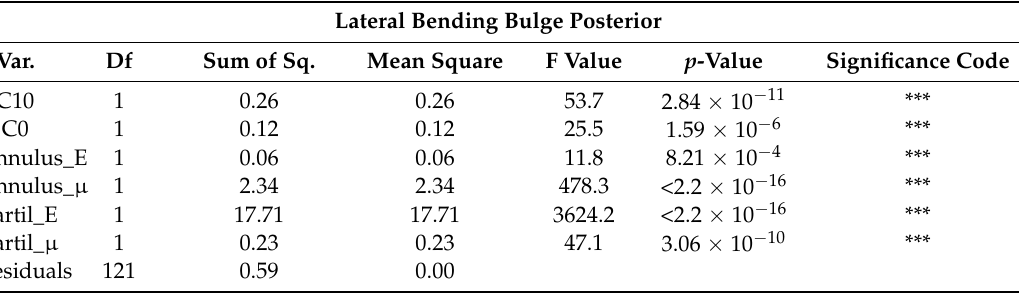
Table 20. ANOVA table for a lateral bending bulge posterior linear model.